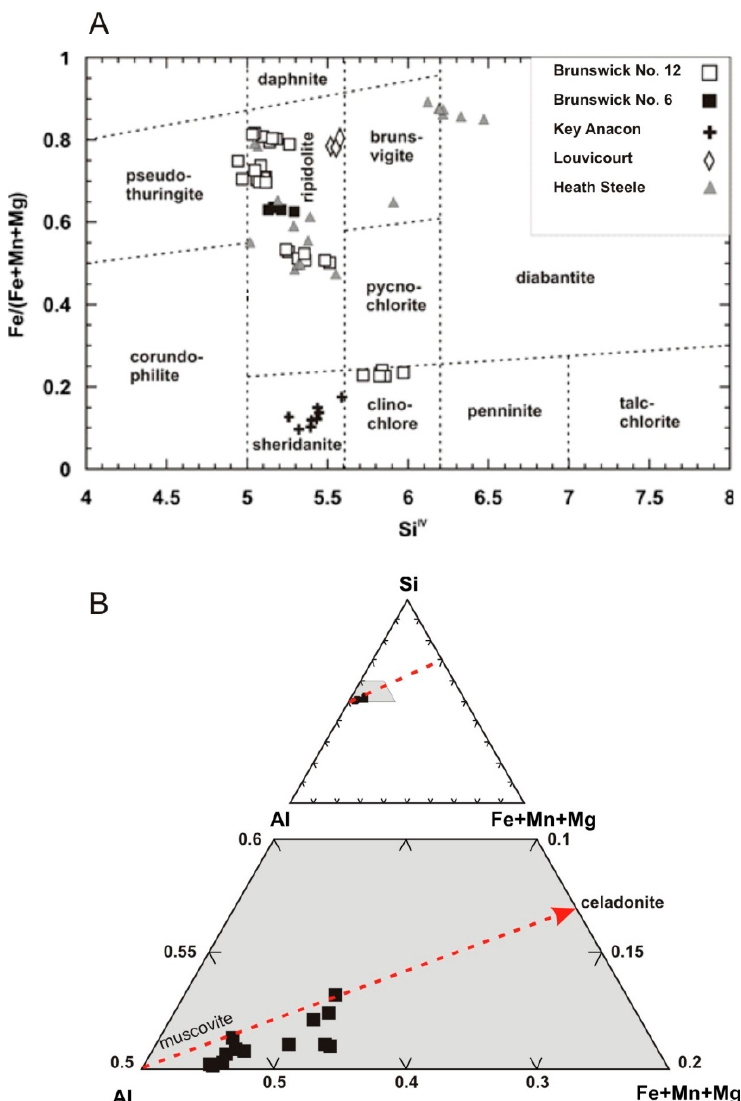
Figure 7. ( A ) Fe/(Fe+Mn+Mg) vs. Si IV discrimination diagram for the classification of chlorite from the BMC (see Supplementary Table S4) and consistent with compositions reported for footwall alteration zones [8,11] and iron formation [46,47]. Field boundaries acquired after [48]. ( B ) Al-Si-(Fe+Mn+Mg) discrimination diagram for 13 electron-microprobe analyses of muscovite from the BMC (see Supplementary Table S5). Note the tight clustering of data points with compositions falling between end member muscovite and celadonite.